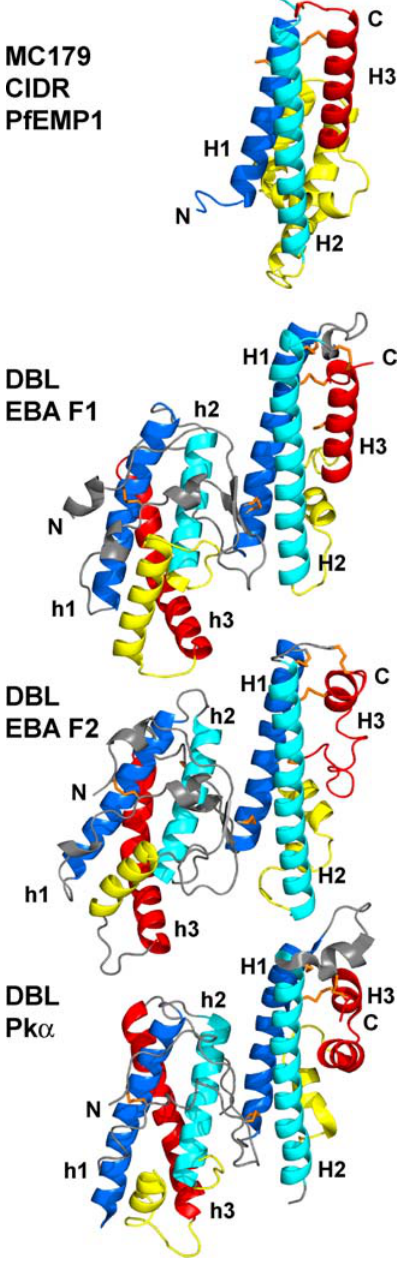
Figure 6. The three-helix bundles of MC179 and the DBL domains. All four structures were aligned using the alpha carbon atoms of the H1 and H2 helices, then were translated apart for viewing. In subdomain 3, the similarity of the H1 (dark blue) and H2 (light blue) helices is apparent, but the H3 (red) helices differ among molecules. MC179 and the EBA-175 F1 DBL each contain regular H3 helices, but the F2 and Pk a DBL domains have irregular H3 helices. Nevertheless, these degenerate helices meander to a pair of conserved cysteines that make conserved bonds to H1 and H2, as in MC179 and in the F1 domain. DBL domains contain another three-helix bundle (h1, h2, h3) in the N- terminal half (subdomain 2) of the molecule that is colored here analogously to the MC179 H1, H2, H3, and connecting helices. Several characteristics of these N-terminal bundles suggest their relatedness to the MC179 bundle and to the C-terminal DBL bundles (see text). N- and C-termini (N, C) are labeled.